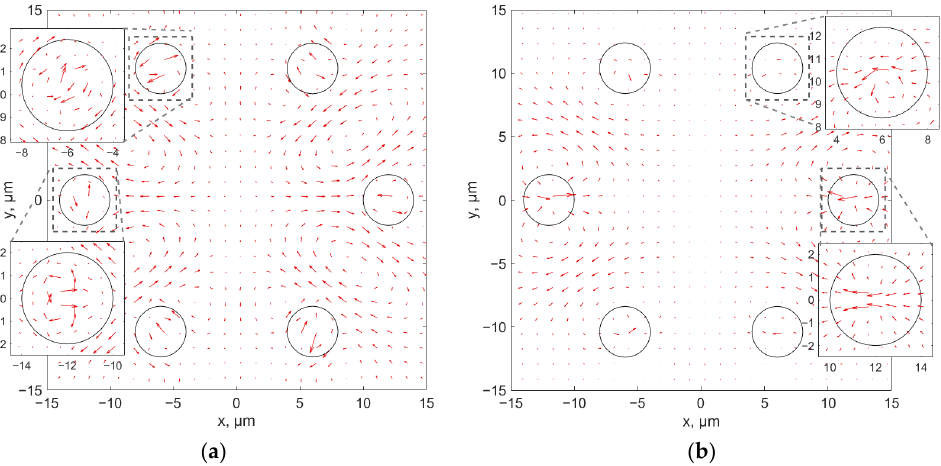
Figure 6. Spin ( a ) and orbital ( b ) parts of the transverse component of the Poynting vector of the fundamental core mode of an ASBGF with parameters given in the text for linear polarization. The calculation was made at a wavelength of 1 µm.